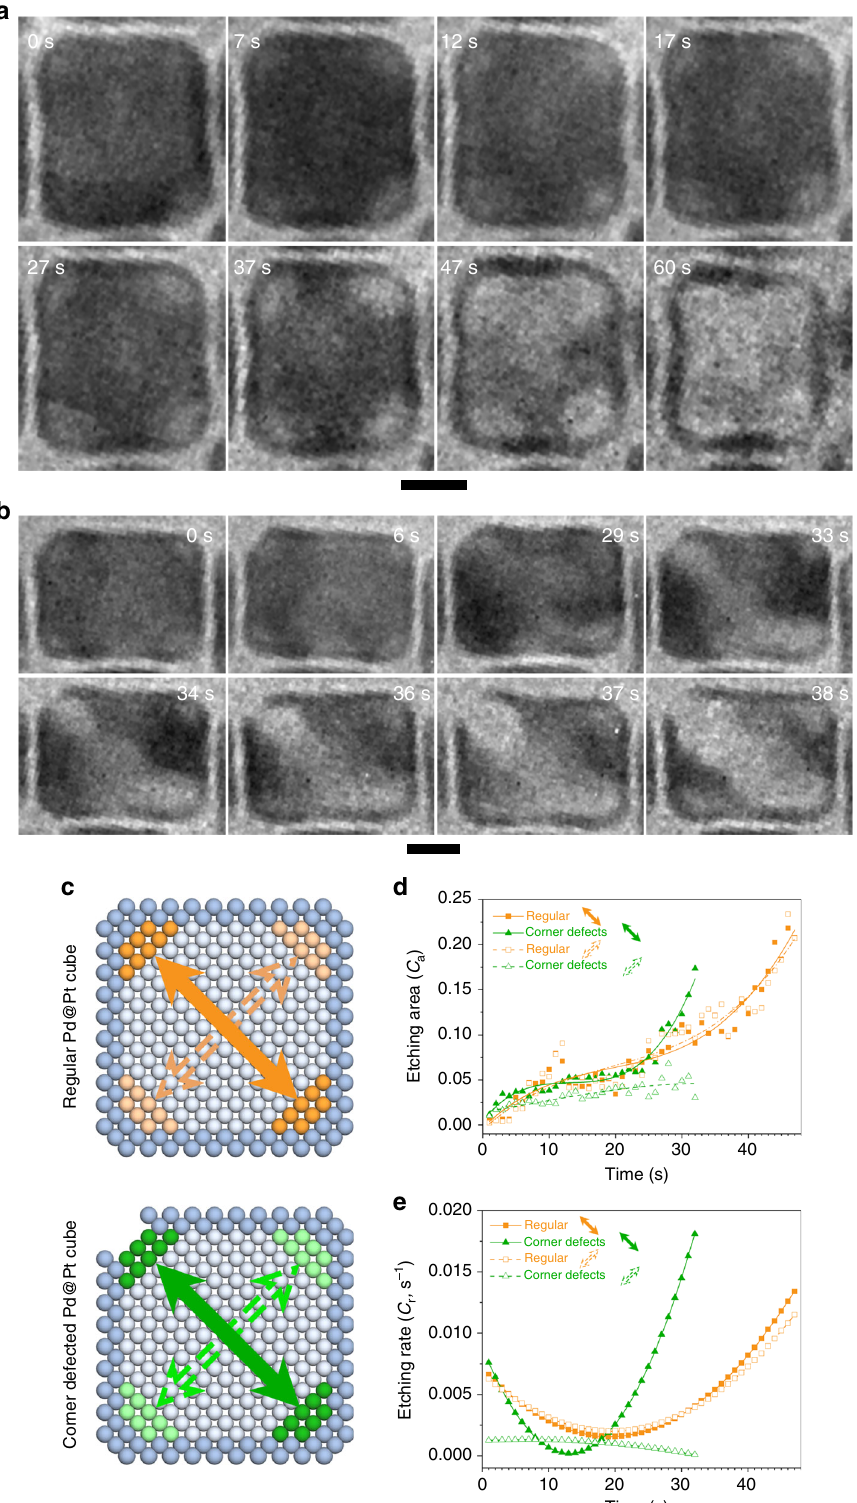
Fig. 1 Etching process of regular and corner defected cubes. a , b Time sequential TEM micrographs showing the etching process of internal Pd atoms in a single regular and corner defected Pd@Pt cube, respectively. Scale bars in all panels are 5 nm. c The illustration of atomic structures demonstrates the calculation of C a . d Scatter diagrams and fi tting curves of C a . e Corresponding rates of etching areas in d , of each direction in two types of